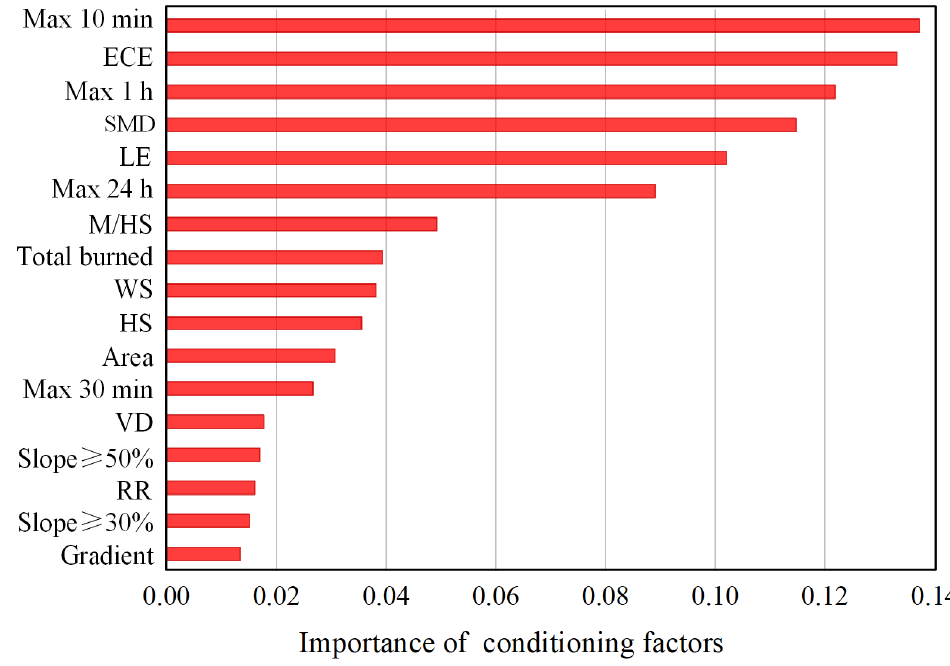
Figure 10. The importance of the post-fire debris flow conditioning factors based on the RF method.